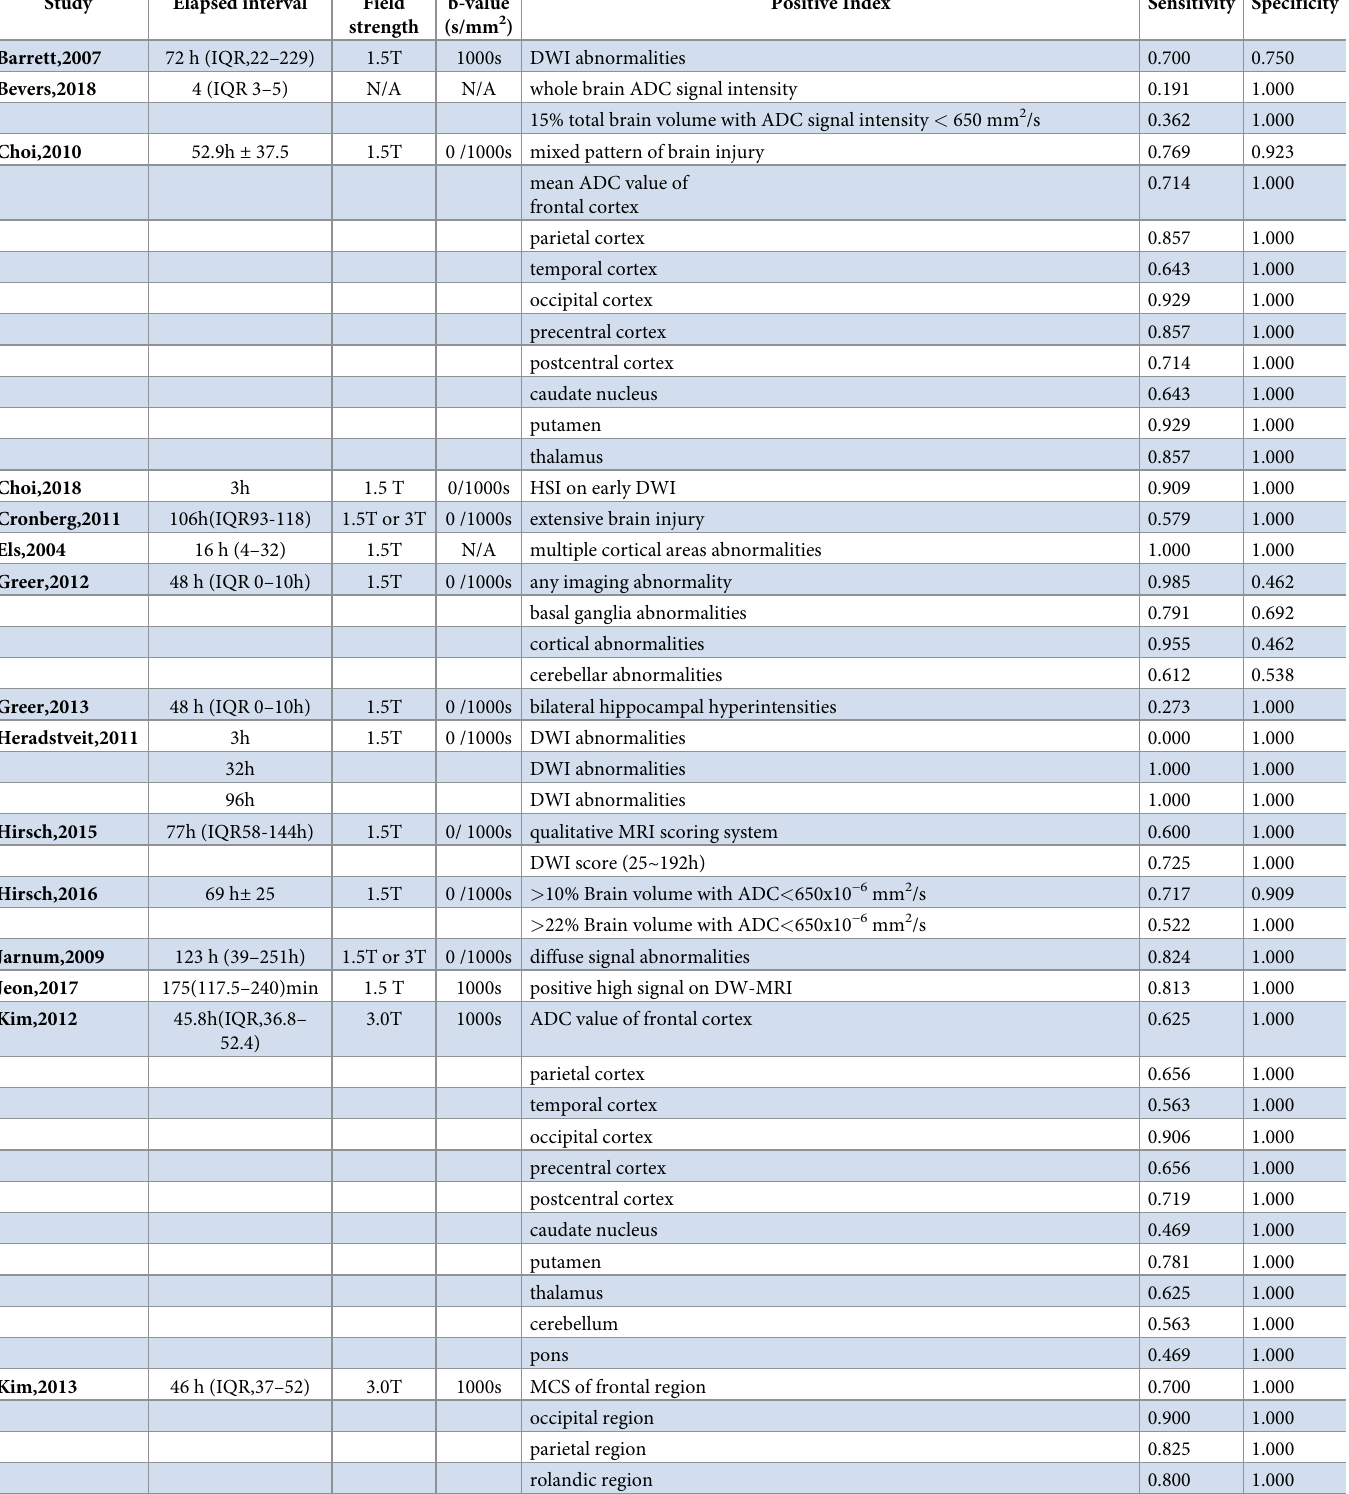
Table 2. Characteristics of the imaging protocol of the enrolled